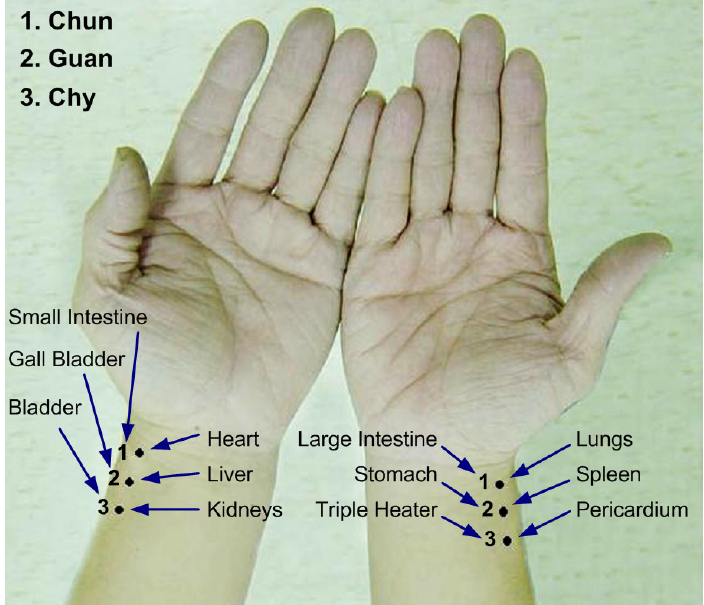
Figure 11. Illustration of palpation positions for pulse diagnosis used in traditional Chinese